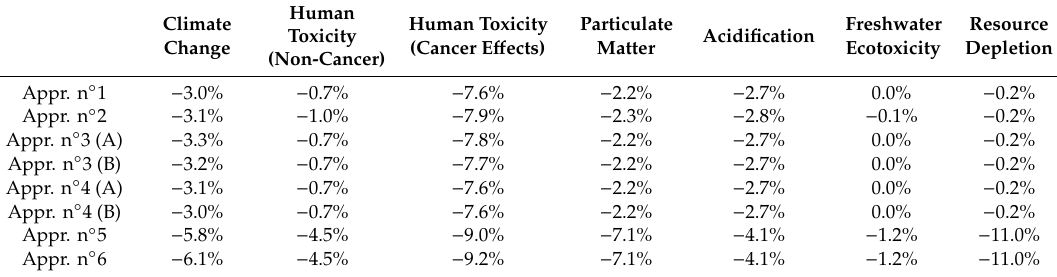
Table A2. Potential contribution of waste management to the environmental profile of electricity production with multi-Si